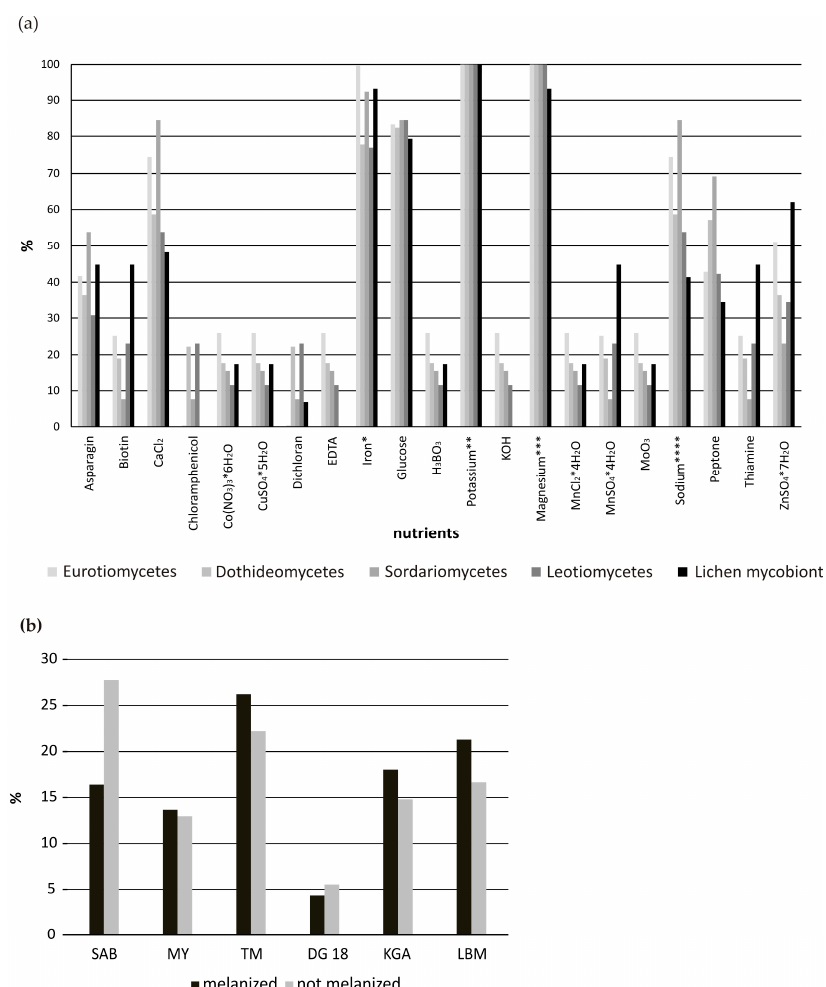
Figure 2. ( a ) Abundance plot showing the growth preference of the five groups of fungal isolates (non-lichenized Eurotiomycetes, Dothideomycetes, Leotiomycetes, Sordariomycetes and lichen mycobionts, mostly Lecanoromycetes) according to the micronutrients present in the culture media. Abundance values are expressed in percentage. The presence of iron, potassium, magnesium and sodium in the medium compounds is summed up as follows: * iron: Fe(NO 3 ) 3 · 9H 2 O, FeSO 4 · · 7H 2 O or iron (from yeast extract); ** potassium: K 2 HPO 4 , KH 2 PO 4 or potassium (from yeast and malt extract); *** magnesium: MgSO 4 · 7H 2 O or magnesium (from yeast and malt extract); **** sodium: NaCl, NaNO 3 ; ( b ) Abundance plot comparing the growth preference of melanized and non-melanized fungi on the six culture media (total number of individuals compared n = 243). DG18: Dichloran/Glycerol agar, KGA: PDA Potato/Dextrose agar, LBM: Lilly and Barnet medium, MY: Malt Yeast-extract, SAB: Sabouraud, TM: Trebouxia